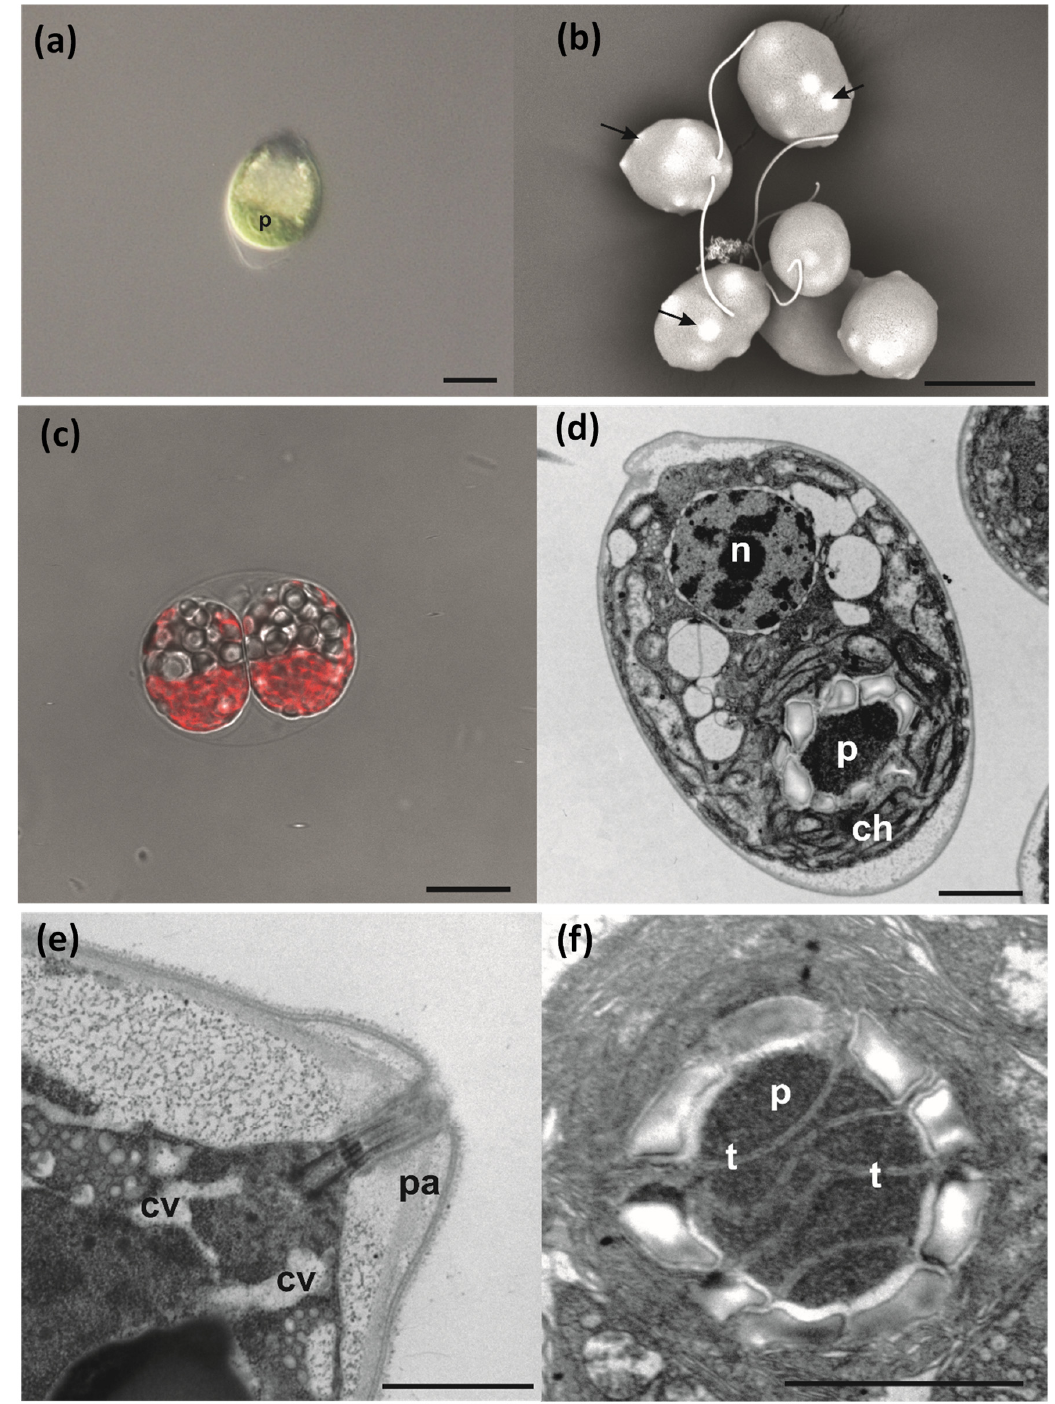
Figure 5. Differential interference contrast ( a ), scanning electron ( b ), confocal ( c ) and transmission electron ( d – f ) microscopy images of Microglena antarctica sp. nov. Single cell showing the cup- shaped chloroplast characterized by the presence of a pyrenoid (p) (a), overview of vegetative cells showing the presence of bulges emerging from the cell surface (arrows) (b), asexual reproduction by sporulation with production of zoospores (c), longitudinal section of a vegetative cell showing a cup-shaped chloroplast (ch) with a pyrenoid (p) and a nucleus in anterior-central position (n) (d), detail of the apical part of the cell showing the papilla (pa) and contractile vacuoles (cv) (e), detail of pyrenoid (p) showing thylakoid membranes (t). Scale bars: 10 µm (a), 10 µm (b), 10 µm (c), 2 µm (d), 1 µm (e), 2 µm (f).